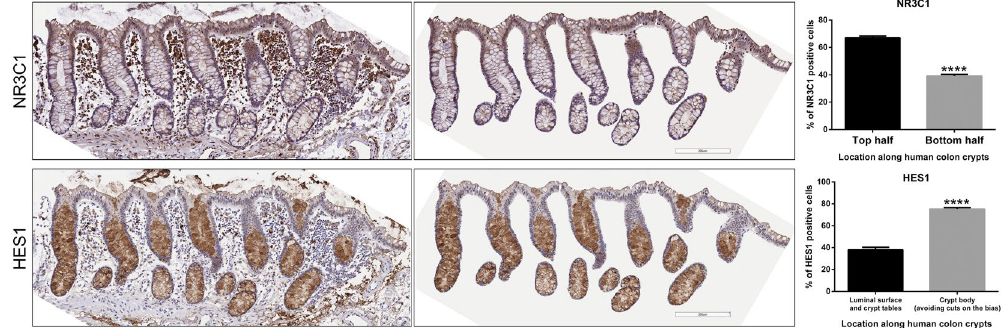
Figure 1. Immunohistochemistry analysis of human colon crypts. Healthy control human colon samples are fixed for Immunohistochemistry analysis. HES1 positive cells showed basal localization and NR3C1 positive cells showed apical localization along crypt axis. ( **** P < 0.0001; n = 24 or 14